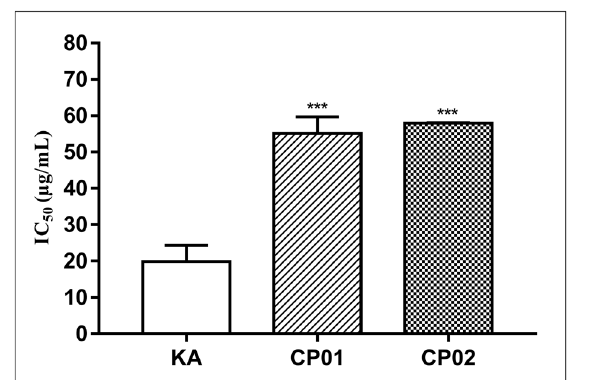
FIGURE 2 - Anti-tyrosinase activities of glycolic extracts of C. pachystachya . Data are presented as means of values ± SD (n = 3). ANOVA followed by Tukey’s test, used as post hoc. Significant values: *** p<0.001, compared to kojic acid. CP01: glycerin (GLY - 70%) and grain alcohol (GA - 30%); CP02: propylene glycol (PG - 70%) and grain alcohol (GA - 30%); KA: kojic